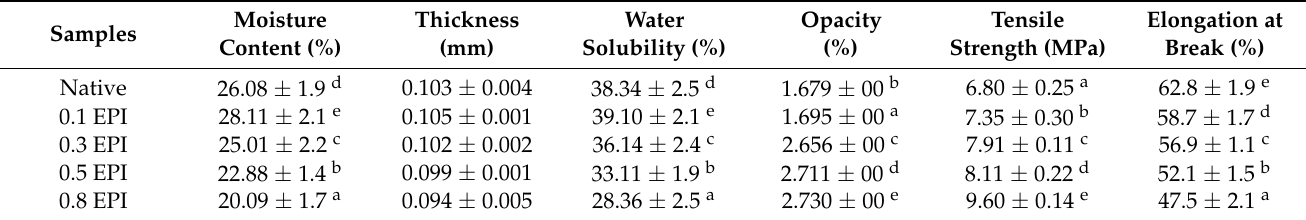
Table 6. Properties of